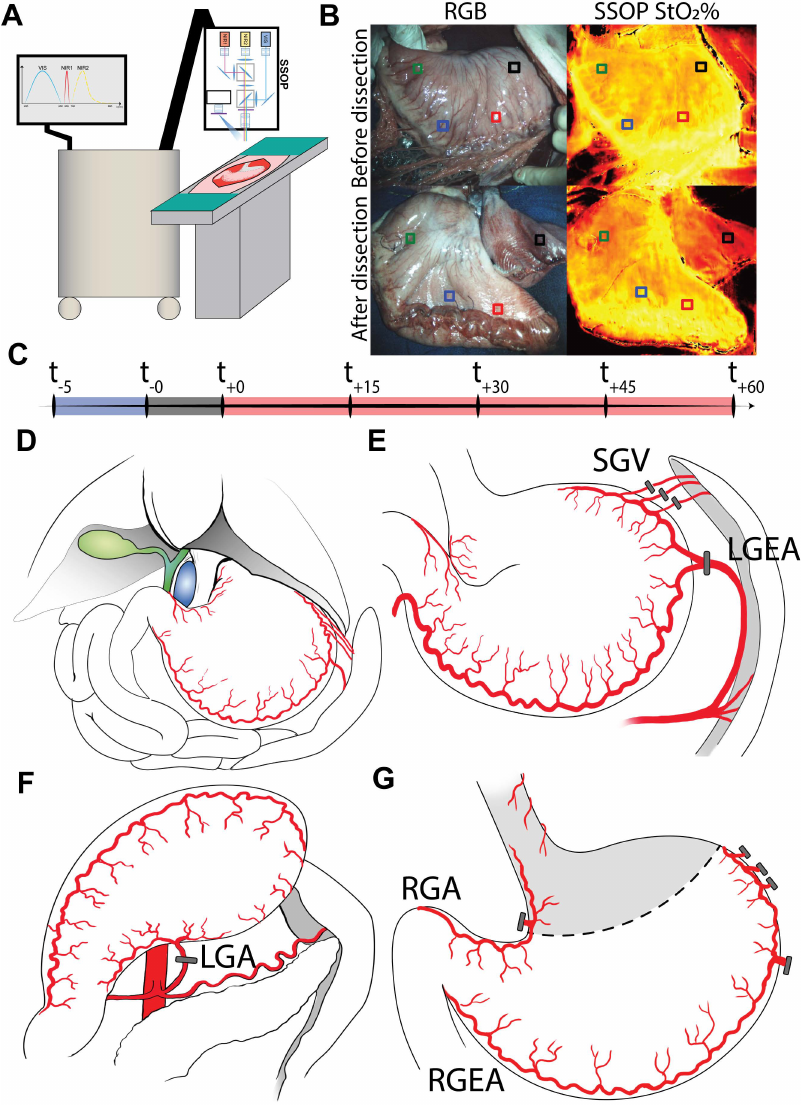
Figure 1. SSOP experimental workflow. ( A ) First of all, the SSOP machine was prepared for data acquisition. ( B ) Regions of interest (ROIs) were marked with surgical stitches before any dissection in order to obtain StO 2 % values and correspondent LCLs in the same ROIs along the entire timeline. Preselection of ROIs for antrum (ROI-A), corpus (ROI-C), fundus (ROI-F), and the future removed region (ROI-R) was essential to prevent any possible selection bias related to postoperative